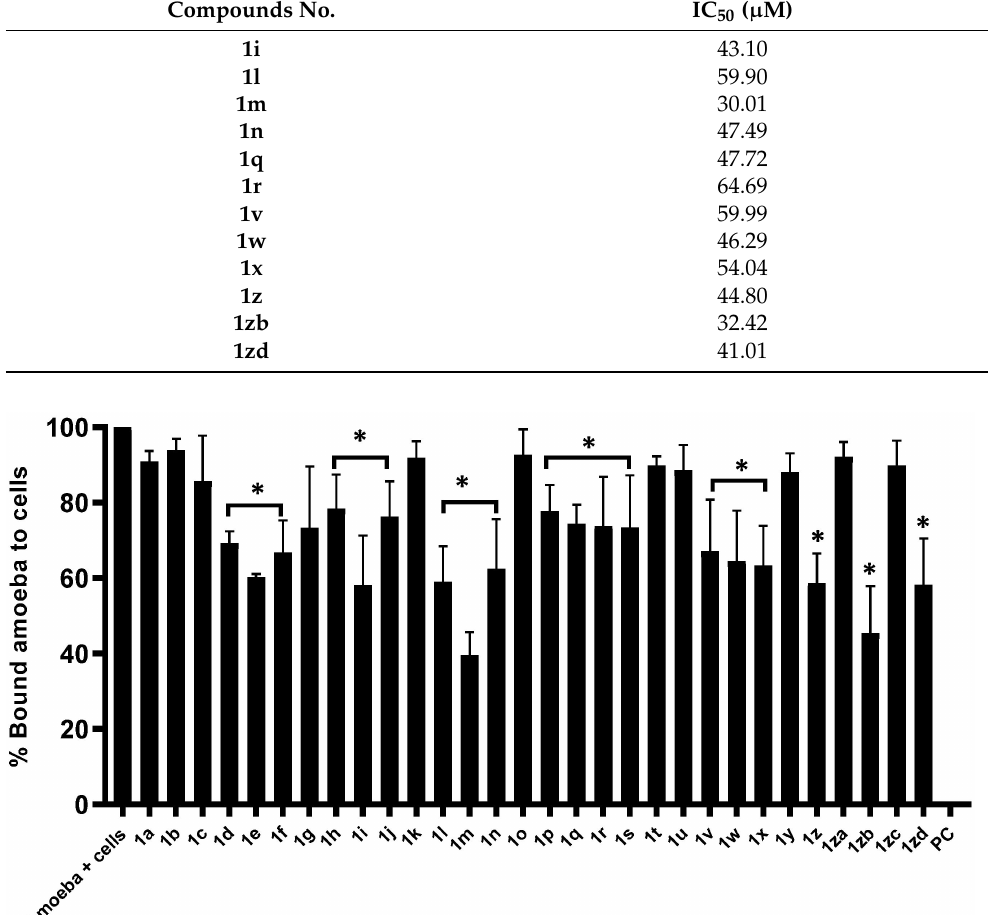
Figure 2. Compounds’ ability to block the A. castellanii binding to HeLa cells. Adhesion assays were accomplished to see whether A. castellanii interact with human cells. Note that compounds and their analogues suppressed A. castellanii significantly. p values were determined using two sample t -test, two-tailed distribution, (*) is p < 0.05. The data are presented as the mean ± standard